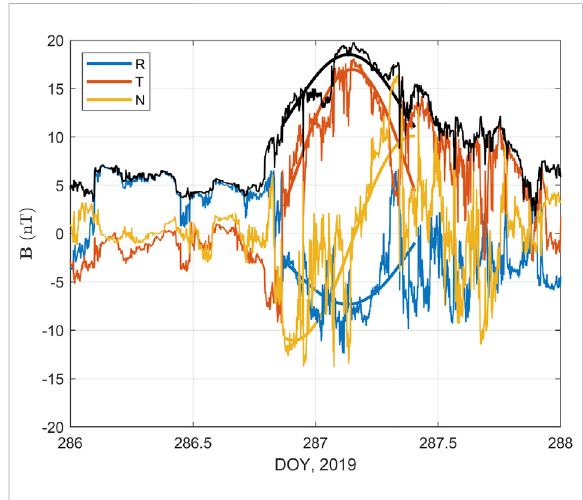
FIGURE 3 The corresponding magnetic fi eld measurements including the magnitude (black) from PSP in the RTN coordinates during day of year, DOY 286 (October 13), and DOY 288, 2019. The smooth curves are the FS model output from the two-spacecraft optimization presented in Modeling and optimization of the ICME magnetic structure .